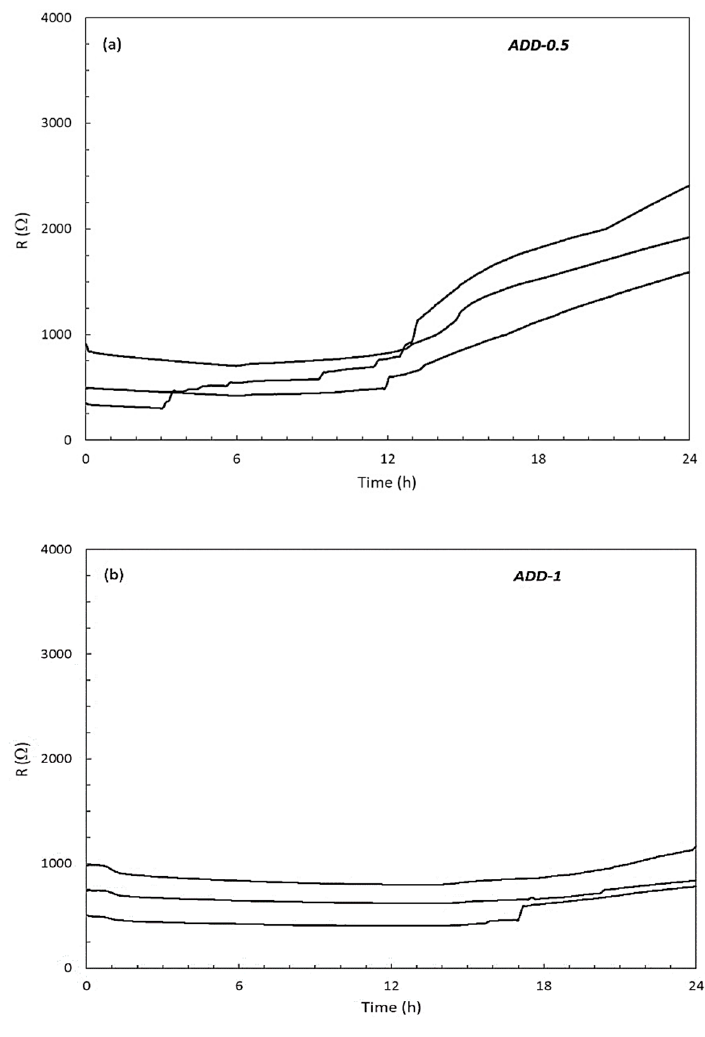
Figure 3. Evolution of the electrical resistance (three sensors per case) during the first curing day of mortar with different content of crystalline admixture. ( a ) 0.45%, ( b ) 0.9%.